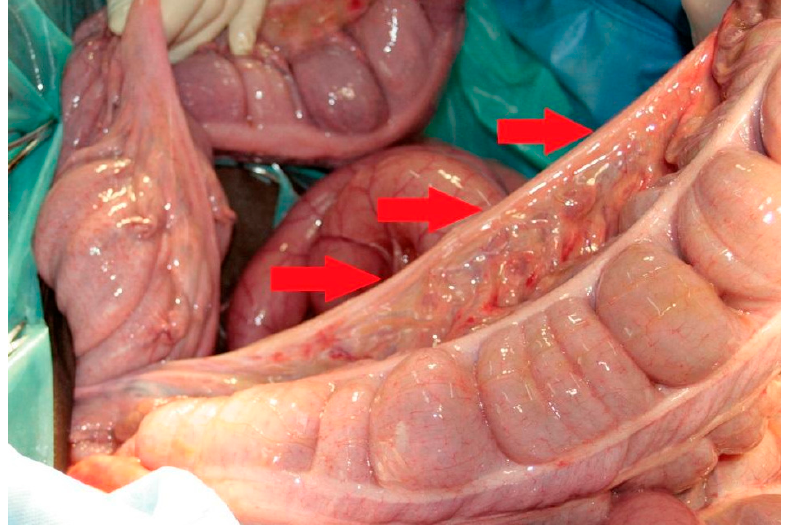
Figure 5. Thickened edge of the mesentery (red arrows).